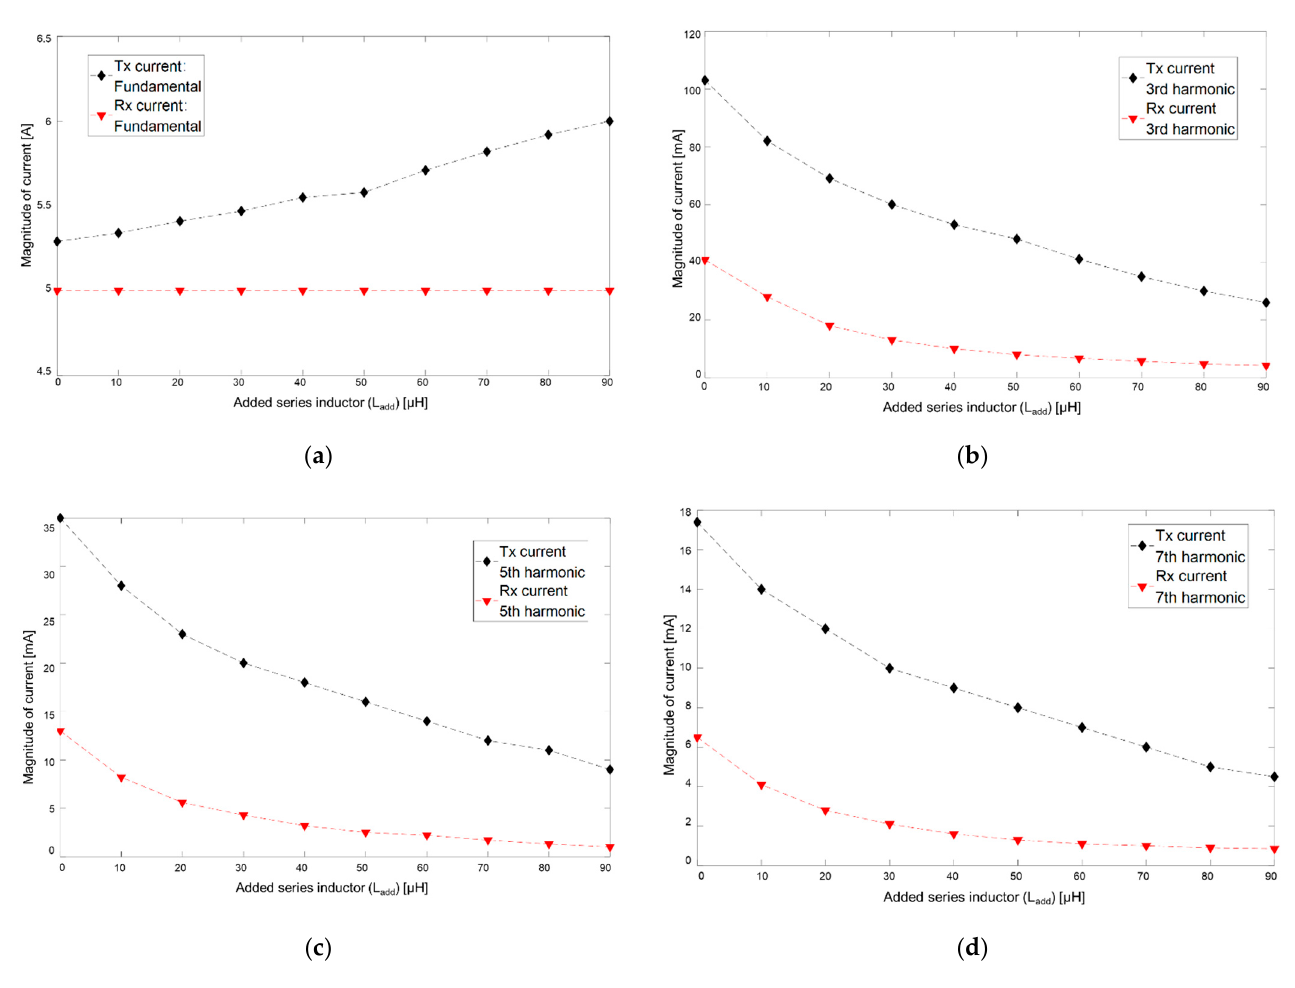
Figure 17. Changes in current harmonic components according to the value of the additional series inductors (L add-tx , L add-rx ): ( a ) fundamental components of Tx and Rx currents; ( b ) 3rd harmonic components of Tx and Rx currents; ( c ) 5th harmonic components of Tx and Rx currents; ( d ) 7th harmonic components of Tx and Rx currents.